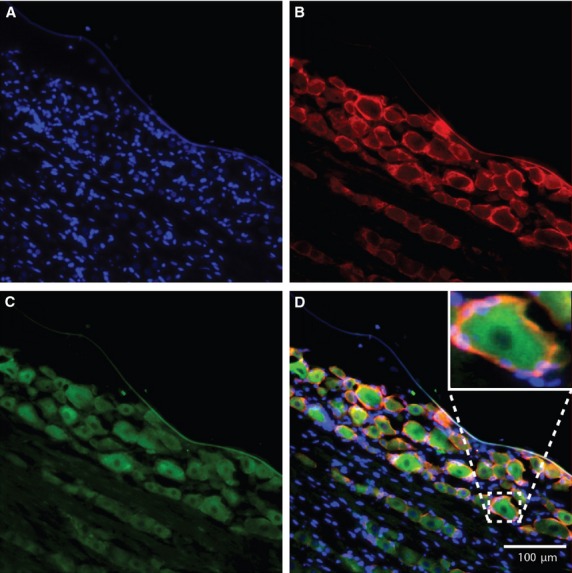
Localization of SNAP-25 in trigeminal satellite glial cells in rat. The blue colour represents the nuclear stain Hoechst, which stains the nuclei of each cell (A). SNAP-25 positive satellite glial cells were identified by double labelling with antibodies against glutamine synthetase, a specific satellite glial cell marker in ganglia (Red: Alexa fluor® 555) (B) and SNAP-25 (Green: Alexa fluor® 488) (C). On the merged image (D) overlapping of the two colours indicates SNAP-25 positive SGCs. The enhanced area on image (D) shows an example of such co-localization of satellite glial cells enveloping a neuron.